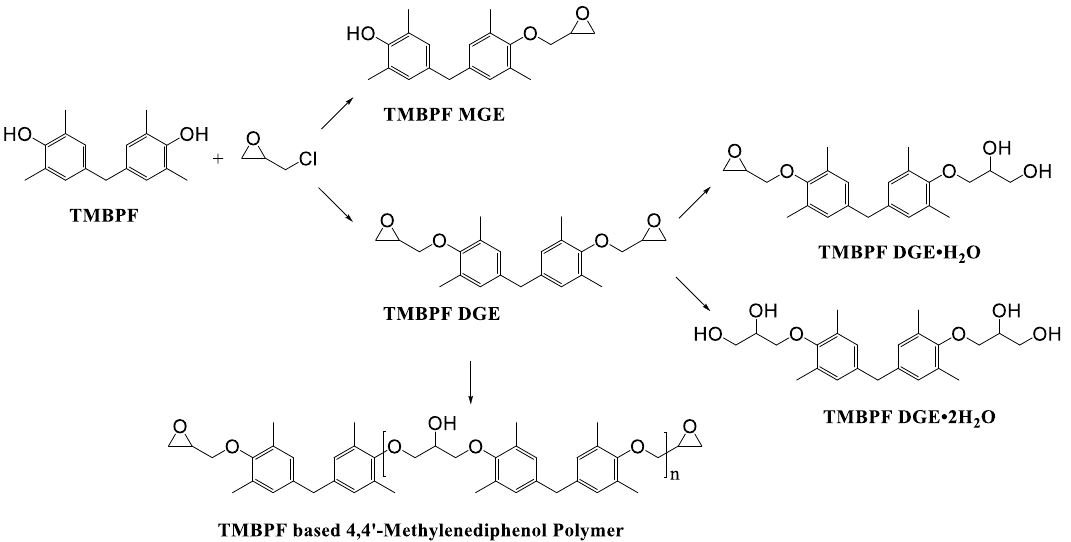
Figure 3. Epoxy TMBPF Formation, polymerization and hydrolysis.